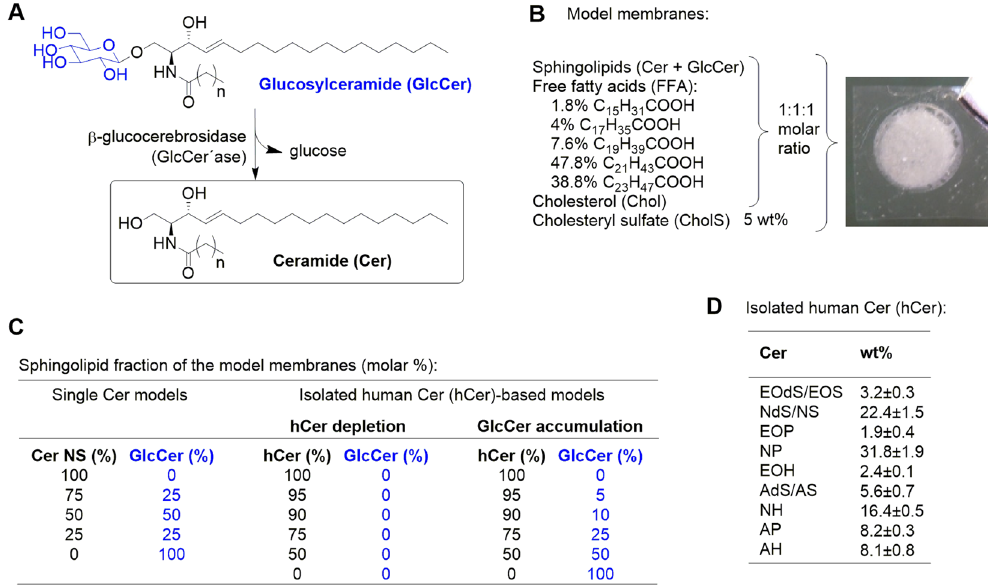
Figure 1. Scheme of the Conversion of Glucosylceramide (GlcCer) to Ceramide (Cer) by β -Glucocerebrosidase (GlcCer’ase) ( A ) and the Composition of the Model Membranes ( B – D ). The model membranes were constructed from sphingolipids (Cer and/or GlcCer, Chol and a mixture of FFA in an equimolar ratio with 5 wt% CholS ( B , C ). For single Cer membranes, N -tetracosanoyl D- erythro -sphingosine (CerNS) was used, whereas the complex model system was constructed from isolated human SC Cer (hCer). The composition of hCer is specified in panel D. To simulate deficient GlcCer-to-Cer processing, the Cer fraction was gradually diminished with or without GlcCer as a replacement ( C